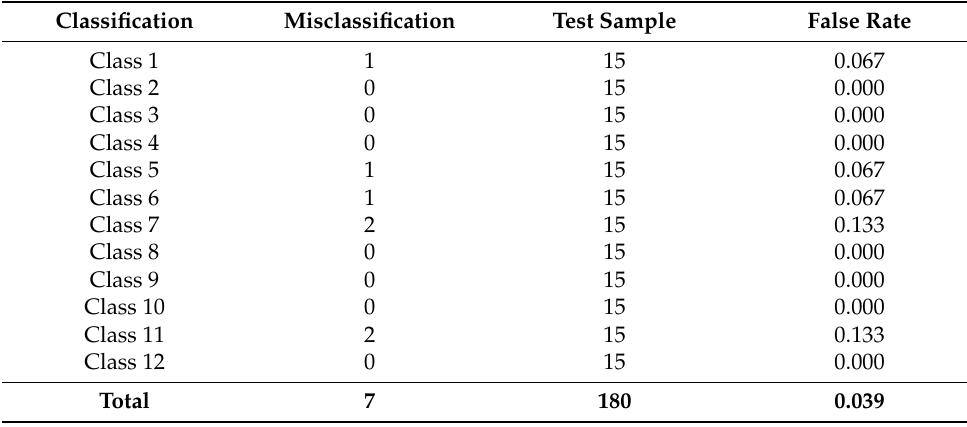
Figure A4. Face recognition of classified images. Table A1. Frontal face static recognition.